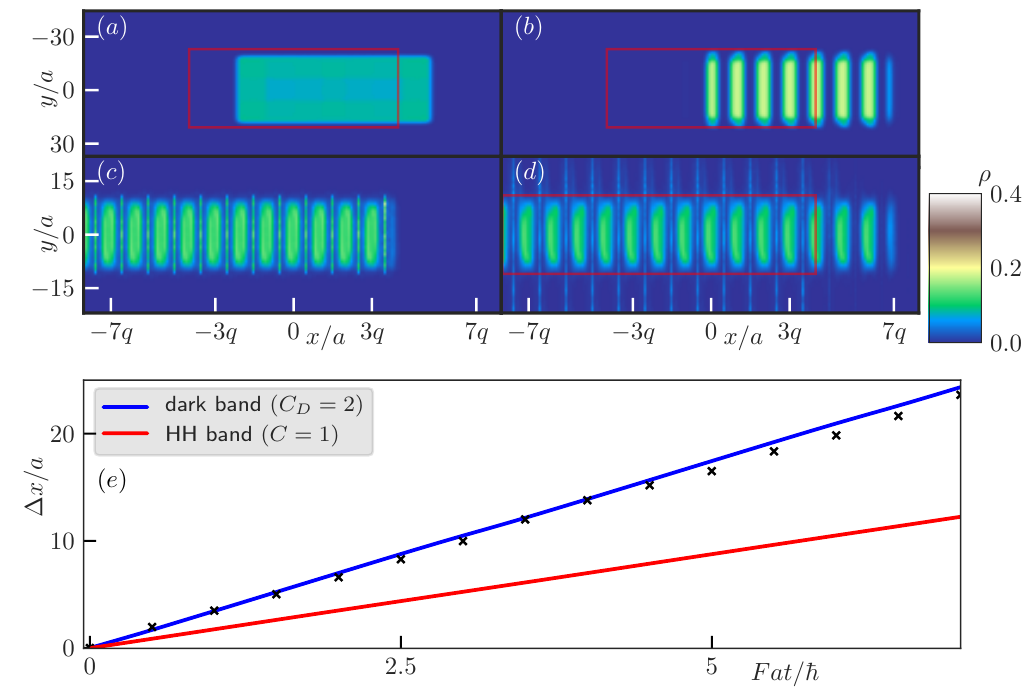
Figure 3: Hall drift in the dark band. (a) Time-evolved density ρ ( x , y ) of non- interacting fermions populating a regular Hofstadter band at flux φ = 1 / 11 (with Chern number C = 1), initially confined within a small region (red rectangle) and then exposed to a linear gradient along y upon release. The evolution duration is t = 10 ( ħ h / Fa ) , the force strength F = 5 · 10 − 4 J / a , and the system size 88 × 44. (b) Same as in (a) but instead of a regular Hofstadter band, one initially populates a dark = 2; see Fig. 2 and related text. The force strength F is the same as state band with C D = 8 · 10 − 2 J , hence allowing for an accu- in ( a ) , and is weak compared to the gap, ∆ db = 1.99 through the center-of-mass drift rate measurement of the Chern number C exp D [ panel (e) and Eq. (14) ] . (c) Density at the end of the proposed loading sequence, using a total ramp duration T = 3 · 10 3 ħ h / J and system size 242 × 22. (d) Time-evolved density of the realistically prepared state, when exposed to the linear gradient along y for the same duration as in (a)-(b), t = 10 ( ħ h / Fa ) ; here we set F = 5 · 10 − 3 ( J / a ) . (e) Center of mass drift for the manually-loaded dark band (blue line) as in (b), the bare Hofstadter band (red line) as in (a), and for the realistically-prepared state (black crosses) as in (c); in the latter case, residual bright-state contributions were filtered ≈ 1.92. out (main text), hence leading to the Chern number measurement of C exp D